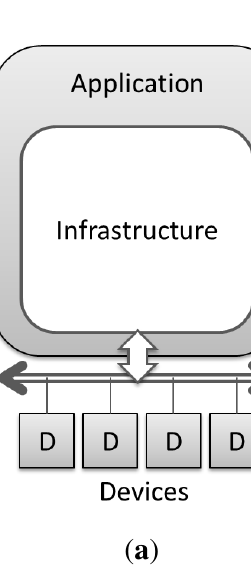
Figure 3. Scaling anti-patterns of IT architectures. ( a ) application handles infrastructure; ( b ) gateway handles